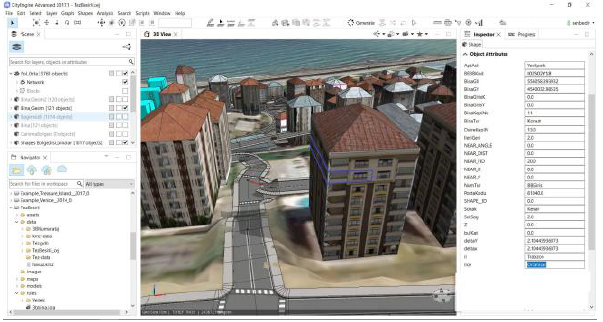
Figure 4 . 3D models of buildings with address data and texture